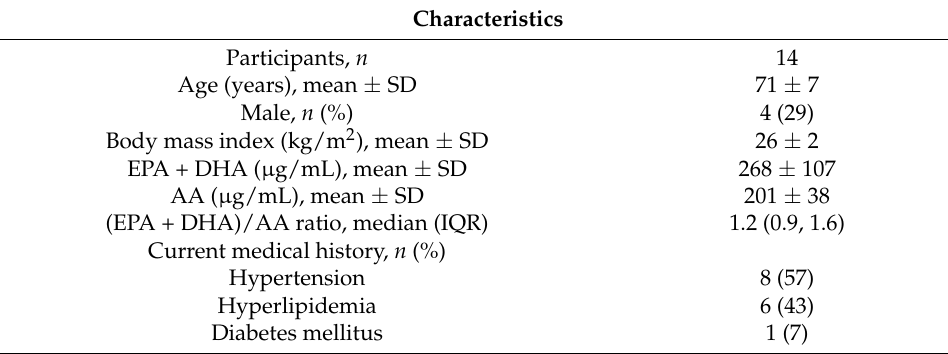
Table 1. Participant demographic and clinical